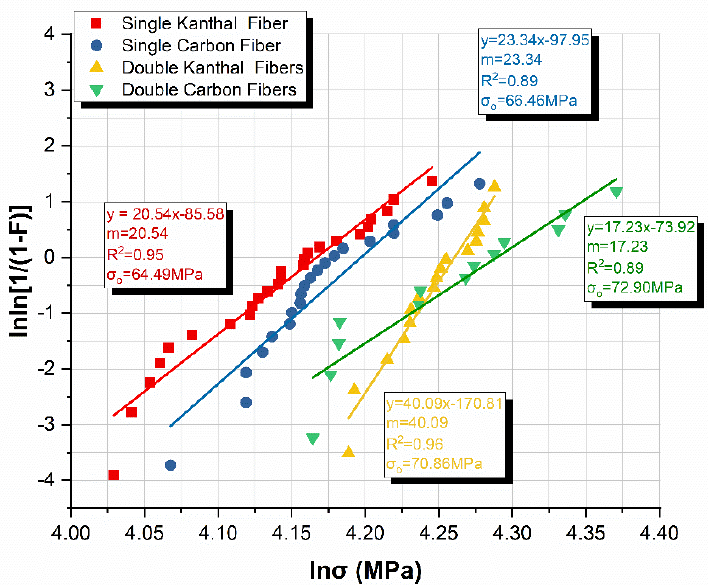
Figure 8. Weibull plot of flexural strength for each type and number of fibers.